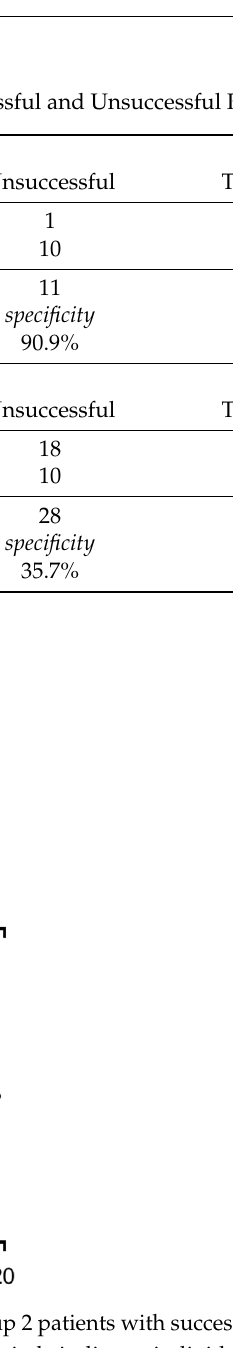
Figure 1. Distribution of discriminant scores in Group 1 and Group 2 patients with suc- cessful returns (successful) and unsuccessful returns (unsuccessful). Each filled circle in- dicates individual